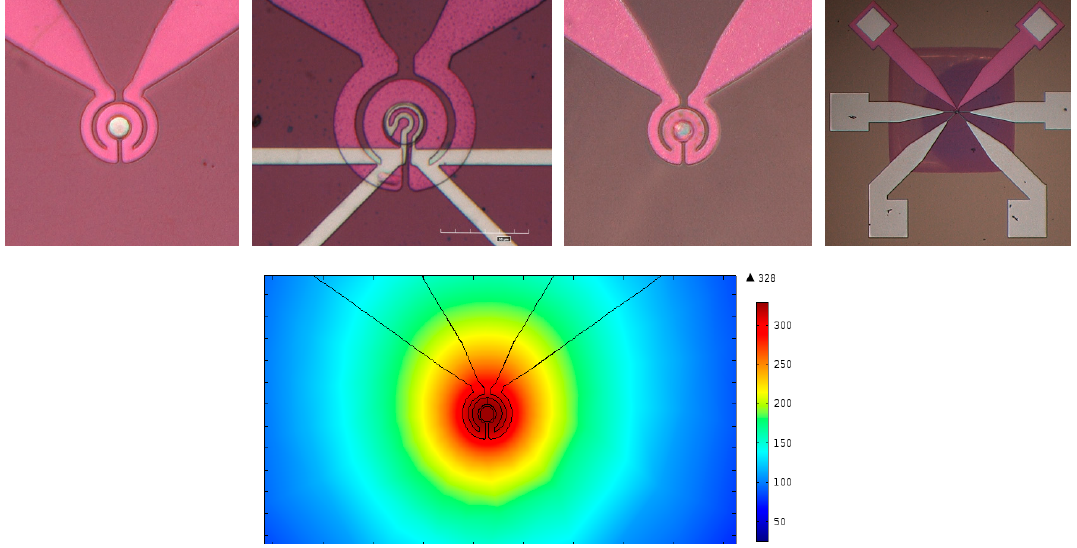
Figure 2. Calibration chips with heating area of 50 × 50 µm 2 and contact area of 10 × 10 um 2 . Top from left to right: 1st design with metallic pad; 2nd design with Pt RTD; 3rd design with the suspended platinum membrane; full chip. Bottom image: FEM simulation using COMSOL showing homogeneous temperature isotropic distribution on the active